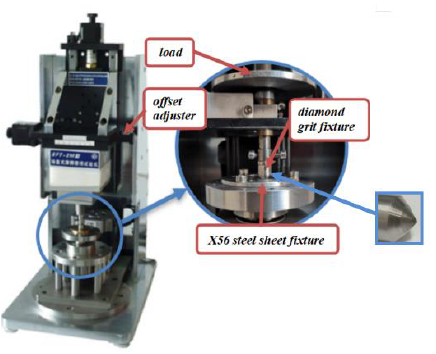
Figure 8. SFT-2M